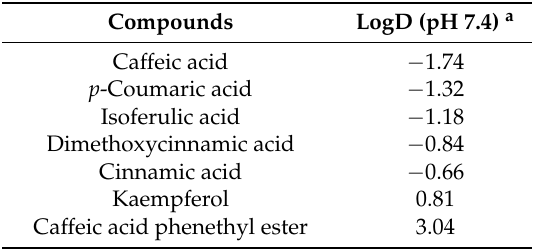
Table 1. LogD (pH 7.4) values of the phenolic